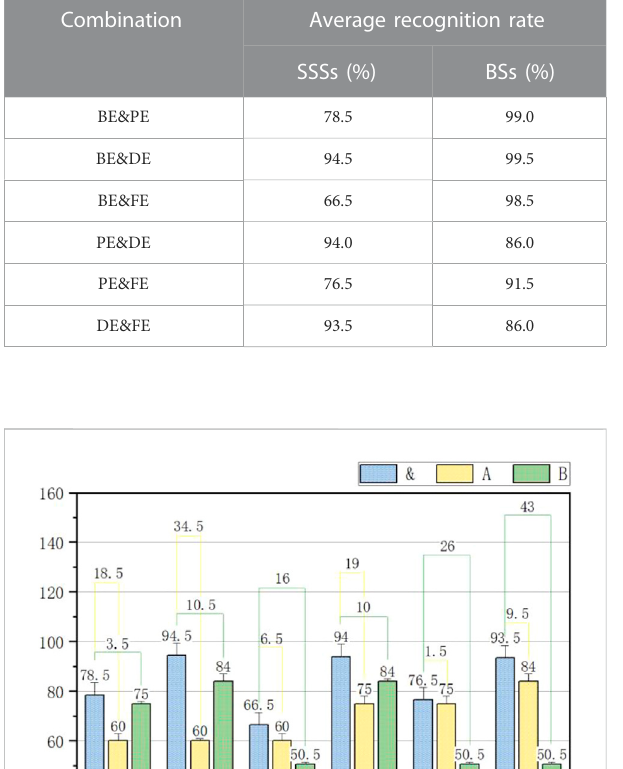
TABLE 4 Average recognition rate of each combination of categories for SSSs and BSs under double features. Combination